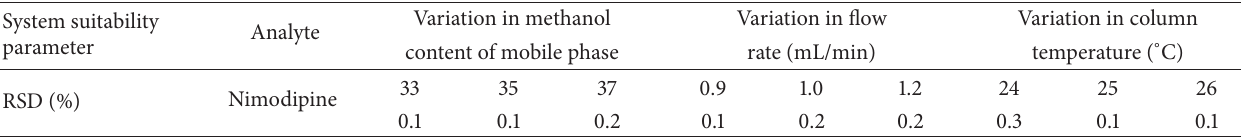
Table 1: Method robustness test results for